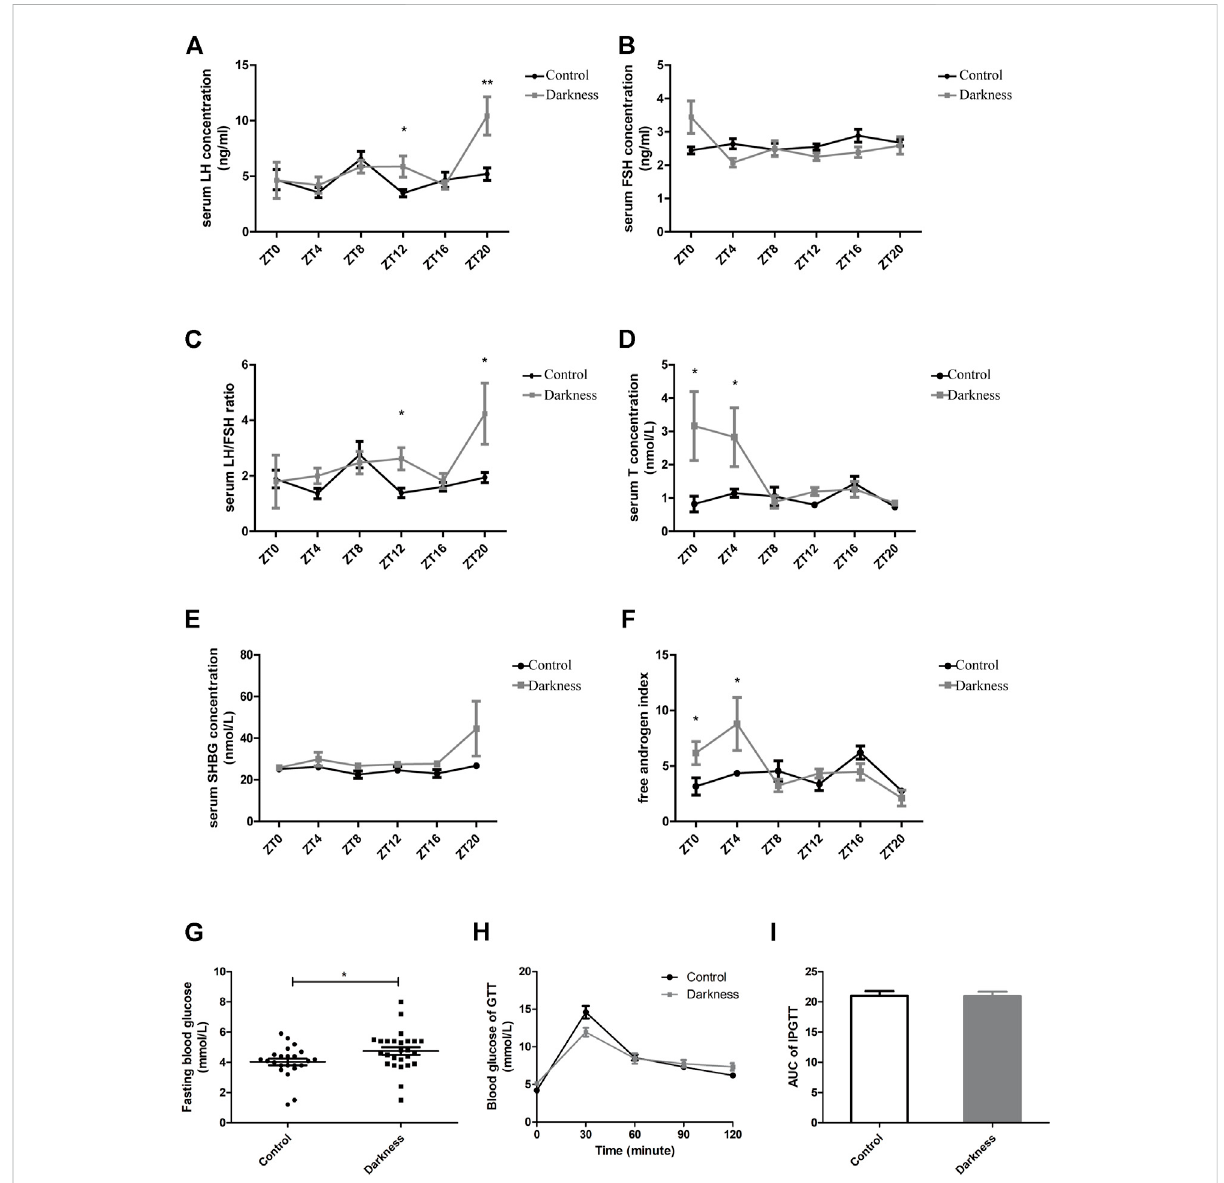
FIGURE 2 Serum hormone pro fi les and glucose metabolism of rats. (A) Serum concentration of LH. (B) Serum concentration of FSH. (C) LH/FSH ratio. (D) Serum concentration of testosterone. (E) Serum concentration of SHBG. (F) Free androgen index calculated by total testosterone plus 100 and divided by SHBG. (G) Fasting blood glucose concentration. (H) Glucose tolerance test. (I) Area under the curve of the GTT test. N = 5/group. Values are expressed as means ± SEM. Signi fi cant differences between the two groups are indicated by asterisks (* p < 0.05 and ** p <